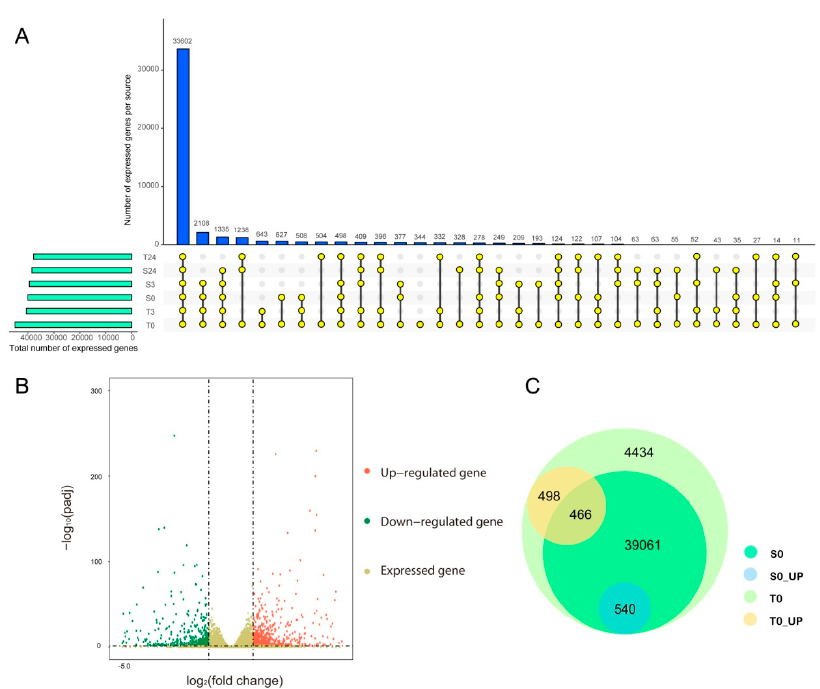
Figure 3. Venn diagram analysis of expressed genes in all samples and analysis of constitutive transcriptional di ff erences between H559 and YM21. ( A ) The number of expressed genes identified in di ff erent samples. The horizontal bar shows the total number of expressed genes identified in each sample. The colored dots connected by lines indicate the sharing of genes between samples, and the number of genes corresponds to the vertical bar above. ( B ) The upregulated or downregulated genes in S0 compared to T0. The colored dots represent genes, where the red dots represent upregulated genes, the green dots represent downregulated genes in T0, and the khaki dots only represent expressed genes. ( C ) Venn diagram of expressed and di ff erentially expressed genes within and between varieties before cold stress.